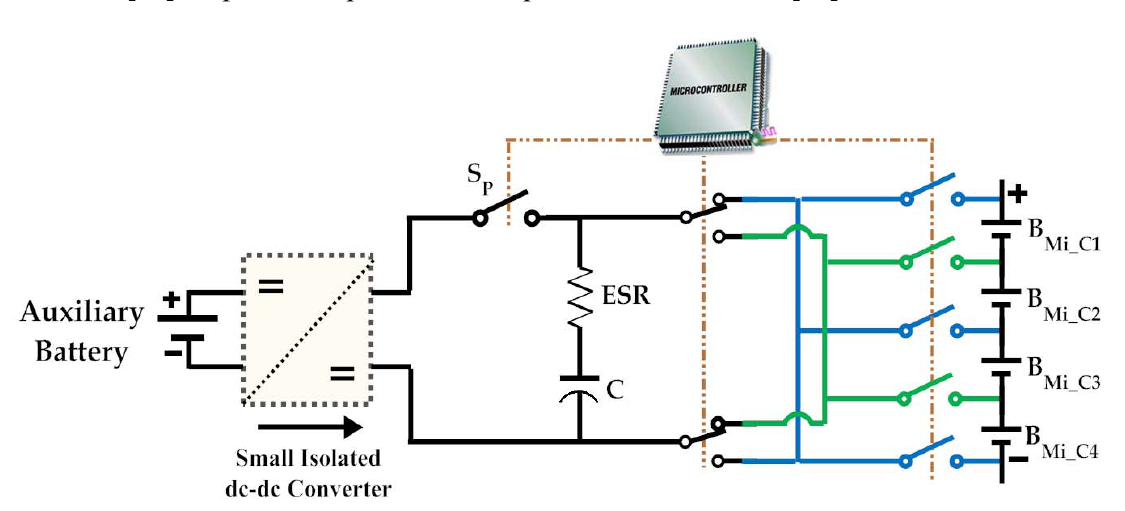
Figure 5. Schematic diagram of module “No. i ” SSC cells balancing with boosting DC converter [39]. Reprinted/Reproduced with permission from 2013